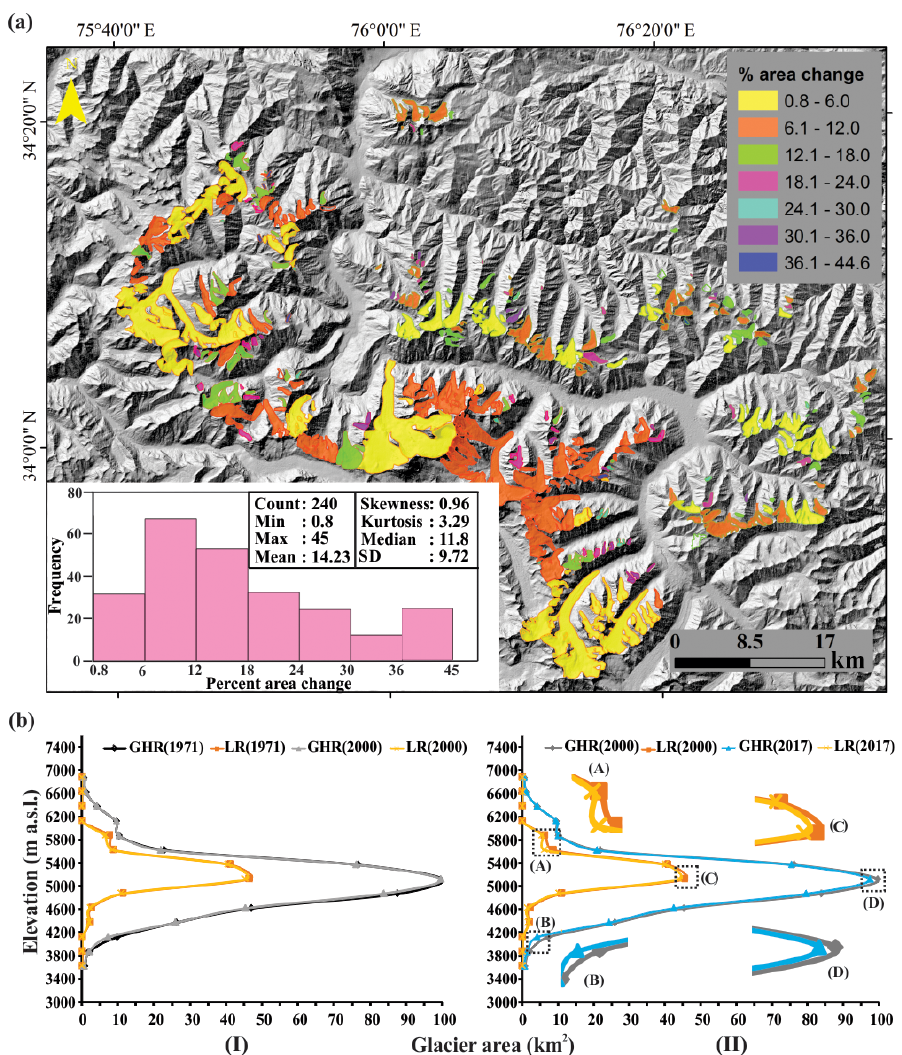
Figure 6. (a) Percentage of area loss of the glaciers in the SSB during the period 1971–2017. Frequency distribution histogram depicting that the majority of the glaciers have undergone an area loss in the range of 6%–12%. (b) Hypsometric distribution of glacier area in the GHR and LR regions during the periods (I) 1971–2000 and (II) 2000–2017. (A), (B), (C) and (D) insets in (II) show the significant change in area at different elevation ranges of the GHR and LR